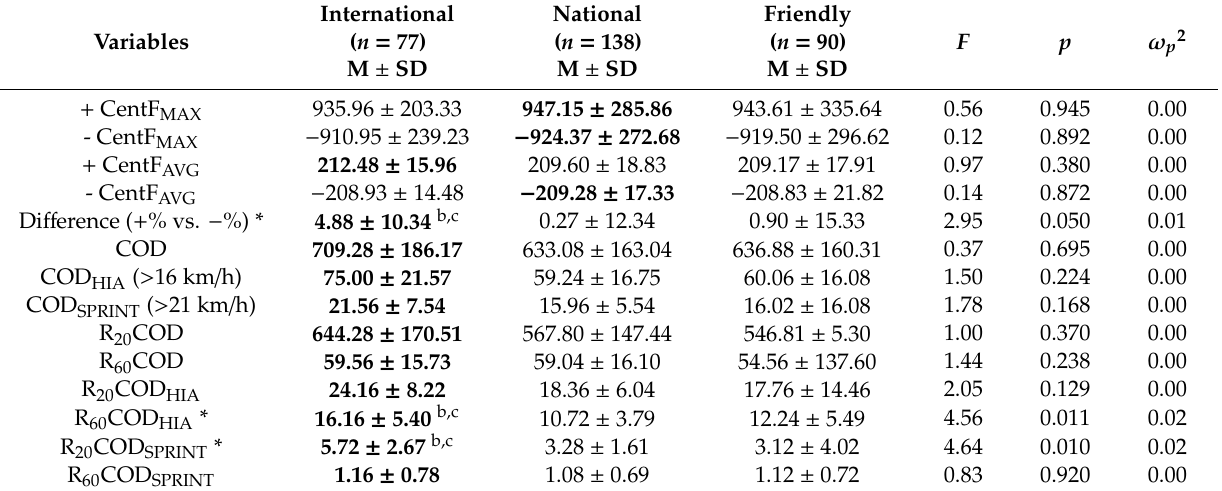
Table 5. Descriptive and comparative analysis of centripetal force and changes of direction related to the type of competition.